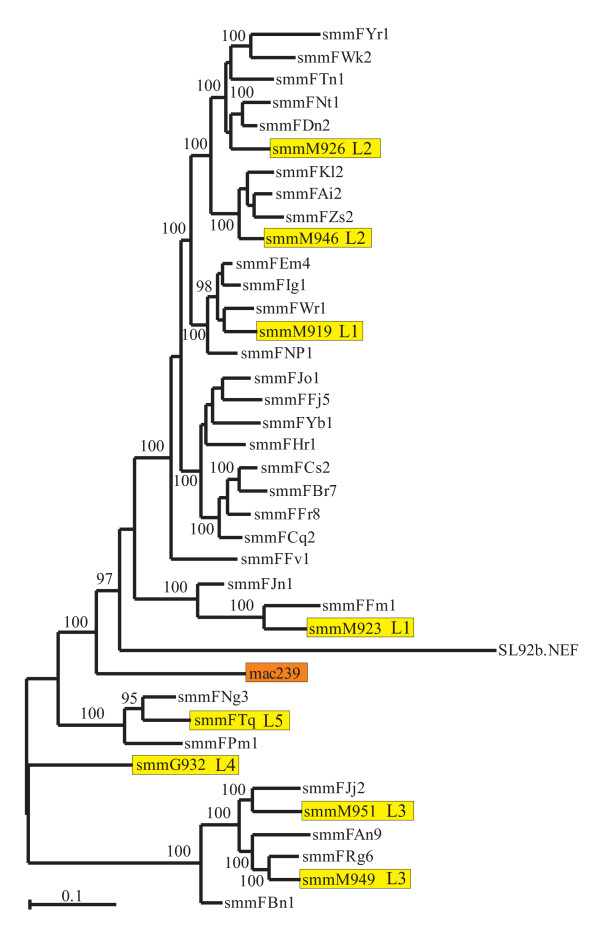
Evolutionary relationships among HIV-2 and SIVsmm Nef sequences. SIVsmm nef alleles newly analyzed in the present study and the SIVmac239 nef are highlighted by yellow and orange boxes, respectively. The tree in was inferred by the Bayesian method [48] MrBayes [49] using 10 million generations and the HKY model [50] with gamma distributed rates at sites [51] and burn in of 25%. Numbers on branches are percentage estimated posterior probabilities. Only those 95% and above are shown.